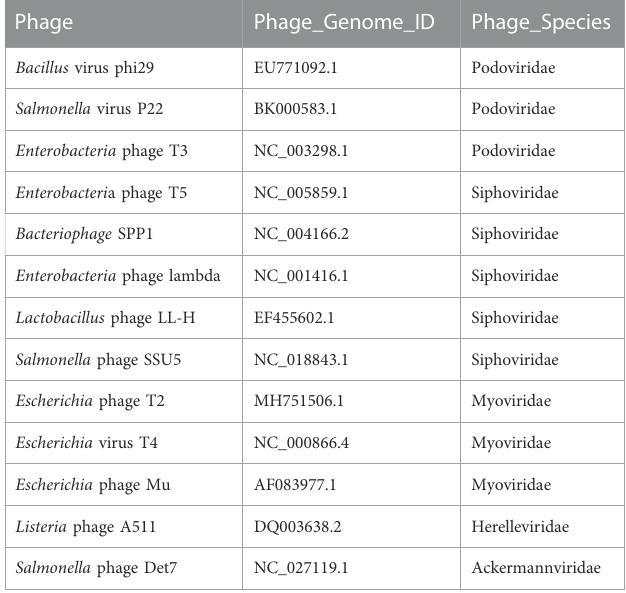
TABLE 1 13 well-de fi ned phage genomes used in the validation